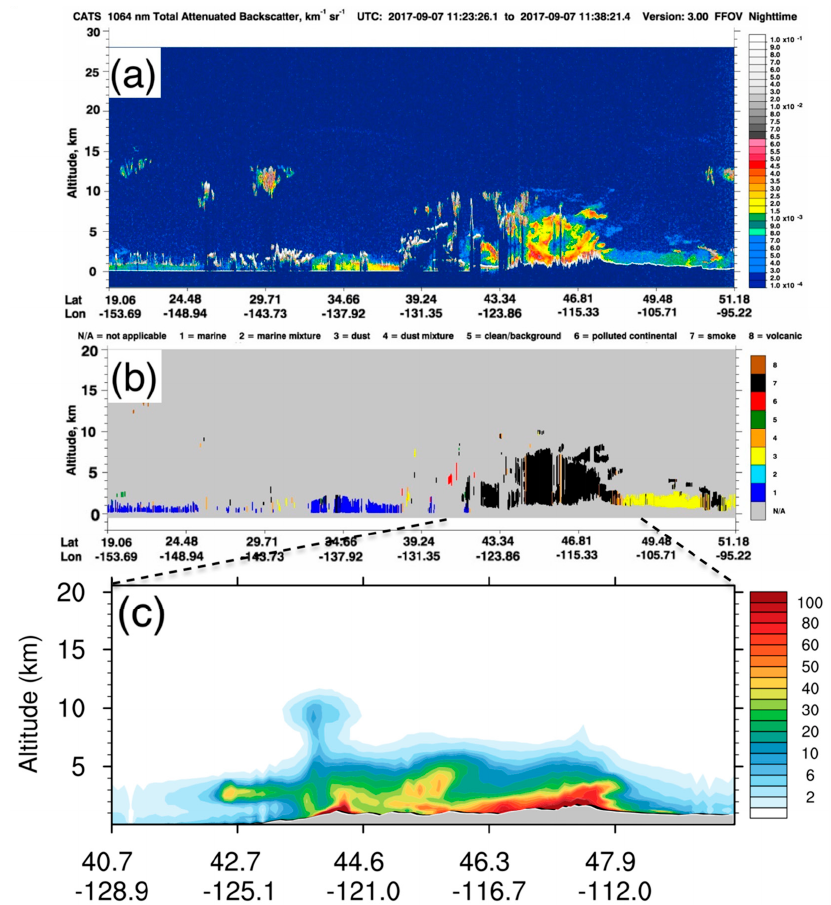
Figure 3. Comparisons of the aerosol vertical distribution at 11:30 UTC (04:30 PDT) on 9/7/2017 between the CATS satellite retrievals and the CMAQ simulation. ( a ) CATS total attenuated backscatter (unit: km − 1 sr − 1 ) at 1064 nm; ( b ) CATS aerosol types; ( c ) 2-D cross section of PM 2.5 concentrations (unit: μ g m − 3 ) from the WRF-CMAQ SENS experiment along the CATS satellite track. Please note that the X-axis range in subplot (c) is different due to the smaller model domain. (credit: The CATS products in subplots (a) and (b) were produced and distributed by NASA Goddard Space Flight Center). CATS: Cloud-Aerosol Transport System. SENS: sensitivity